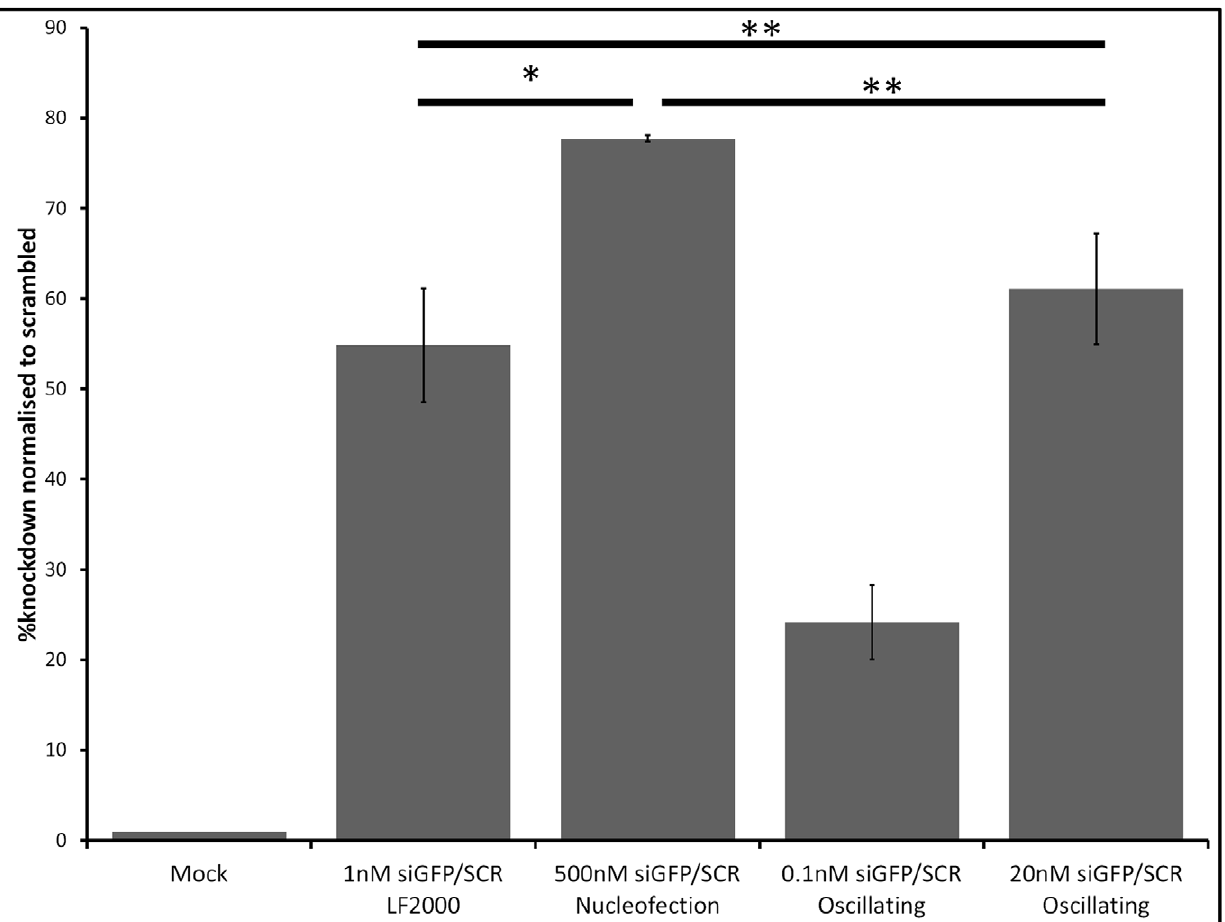
Figure 2. Knockdown of GFP from GFP-HeLa cells. Stably-expressing GFP-HeLa cells were transfected, either with a lipid reagent, nucleofection method or magnetofection using an oscillating magnet (2Hz frequency amplitude and 0.2 mm displacement), as indicated. Magnetofection using nTMag only was set as negative control (Mock). Fluorescent intensity (Median) was determined 72 hr post-transfection and knockdown levels were normalised to a scrambled control. Results are expressed as the mean 6 SD of at least three independent experiments. *, p , 0.05; **, p $